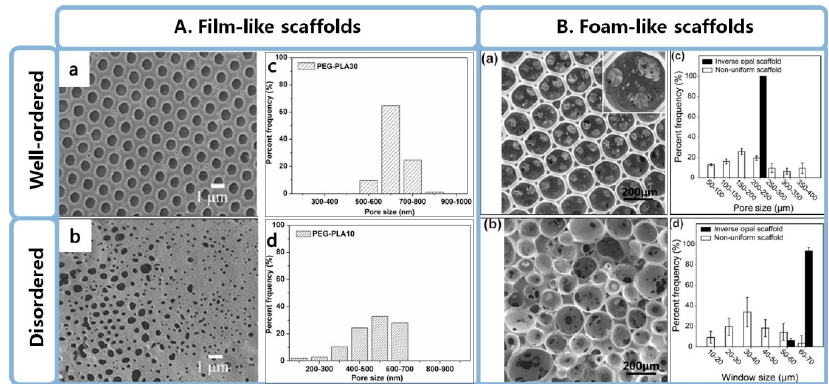
Figure 2. ( A ) SEM images and size distribution of (a,c) PEG-PLA30 and (b,d) PEG-PLA10 porous films fabricated by the breath figure templating technique. Percent frequency (%) refers to the percentage of the pore size within a certain range. Reprinted from [25] with permission. Copyright 2015 Elsevier. ( B ) SEM images of (a) an inverse opal scaffold and (b) a non-uniform scaffold, and size distribution of (c) pores and (d) windows (or the holes connecting adjacent pores) in each scaffold. The black and white bars correspond to the inverse opal and non-uniform scaffolds, respectively. Reprinted from [32] with permission. Copyright 2010 American Chemical Society.